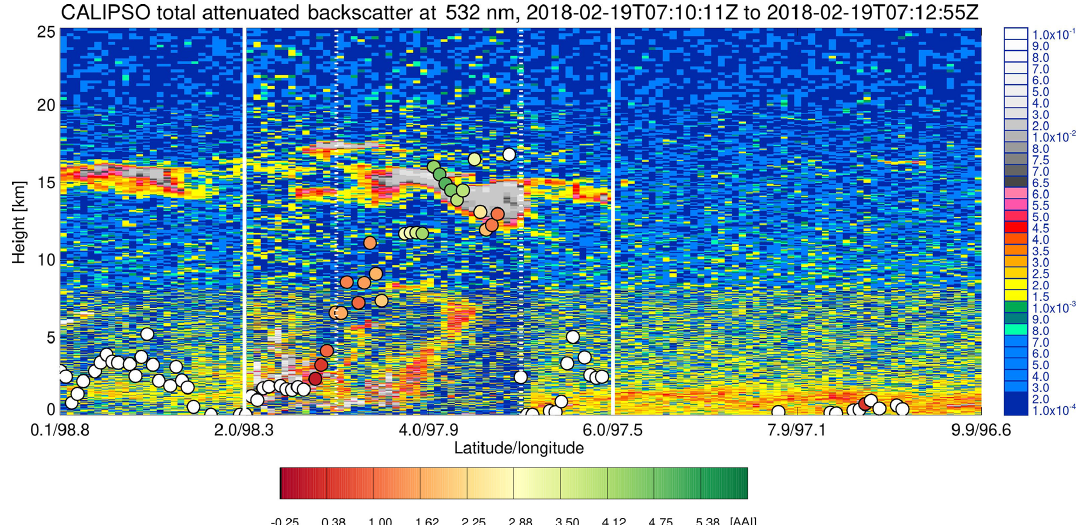
Figure 2. CALIOP total attenuated backscatter profile for the Sinabung eruption on 19 February 2018 along the track indicated in Fig. 1. The circles denote the TROPOMI FRESCO cloud heights, color-coded according to the TROPOMI AAI values as in Fig. 1. White dots indicate AAI values<0.